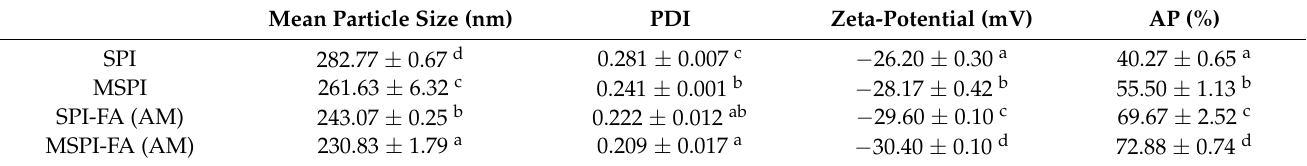
Table 1. Characteristics (mean particle size, polydispersity index , zeta-potential, and AP) of emul- sions stabilized by different modified soybean protein